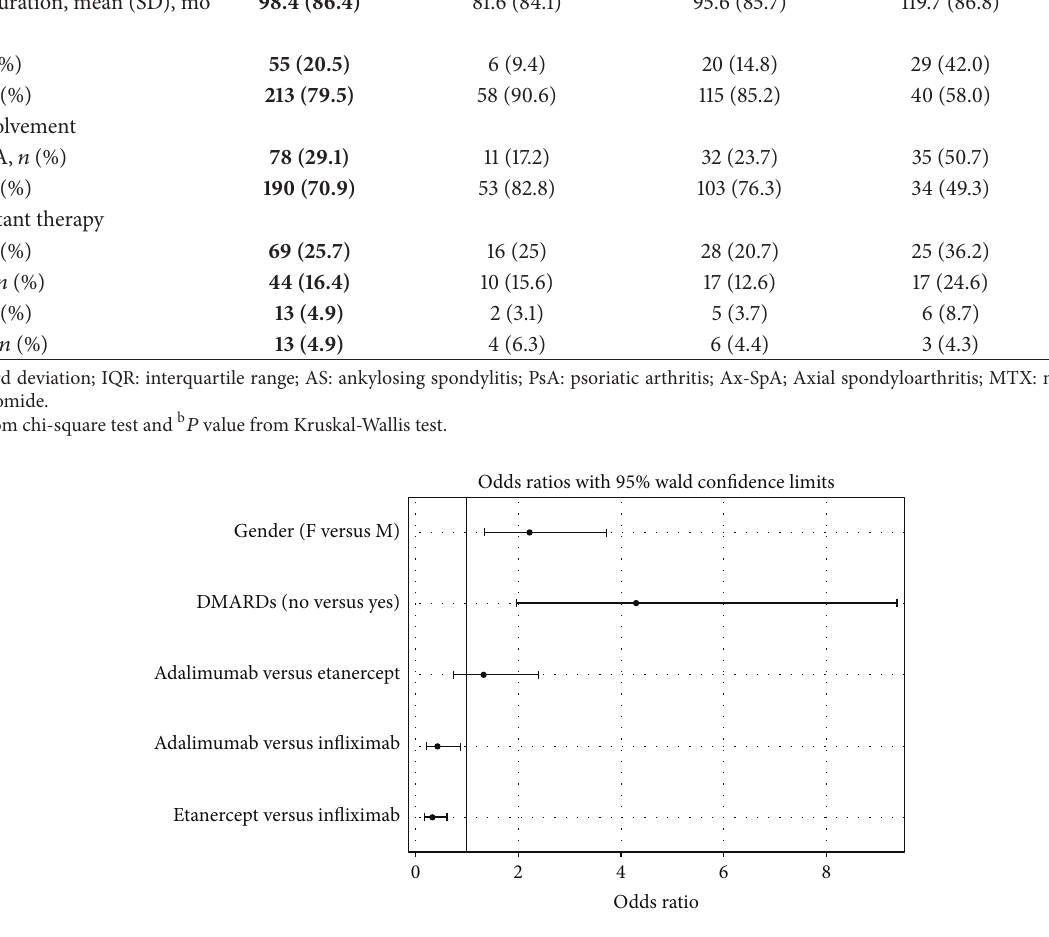
Figure 1: Odds ratios for treatment persistence